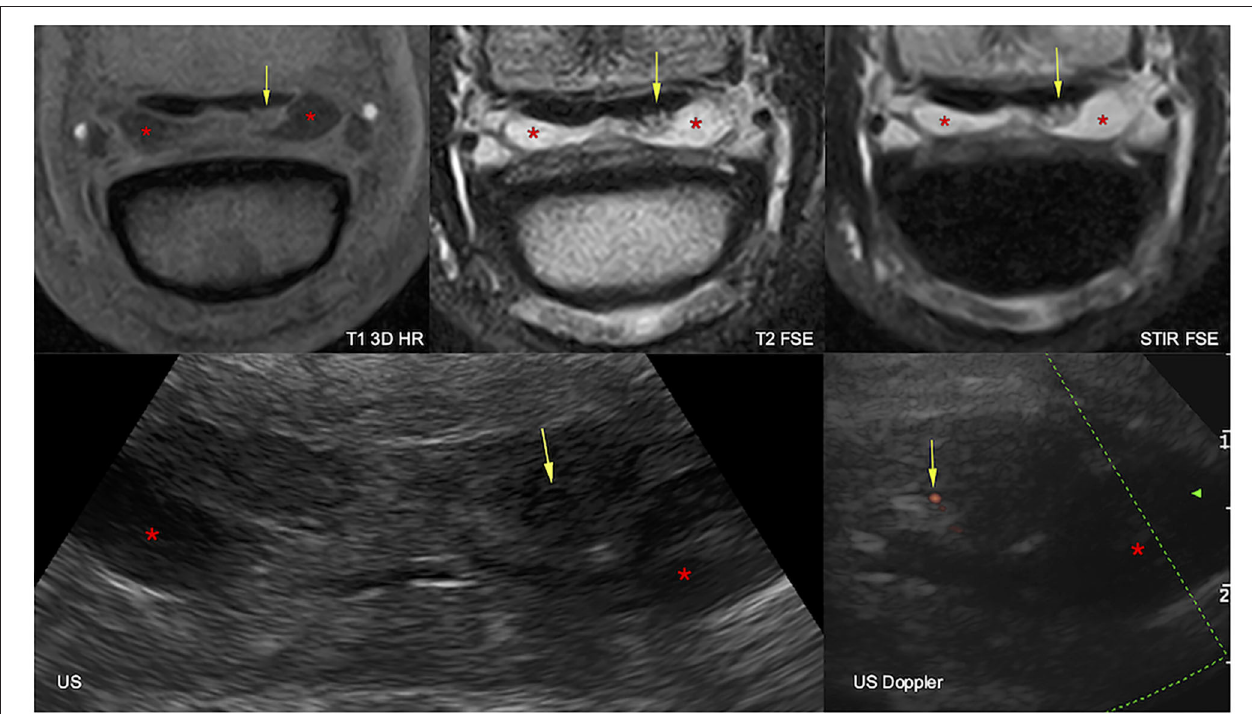
FIGURE 2 | Transverse magnetic resonance imaging (MRI, top) and ultrasonographic (bottom) images of the right front foot at the suprasesamoidean level: lateral is to the right and dorsal to the bottom. The lateral lobe of the deep digital flexor tendon is increased in size and deformed by a dorsal lesion, hyperintense in all MRI sequences, hypoechoic, and vascularized at ultrasound (arrows). The navicular bursa is moderately effused (asterisks). T1 3D HR, high resolution tridimensional gradient echo T1 weighted sequence; T2 FSE, fast spin echo T2 weighted sequence; STIR FSE, fast spin echo short tau inversion recovery weighted sequence; US, ultrasonography; US Doppler, Doppler ultrasonography.